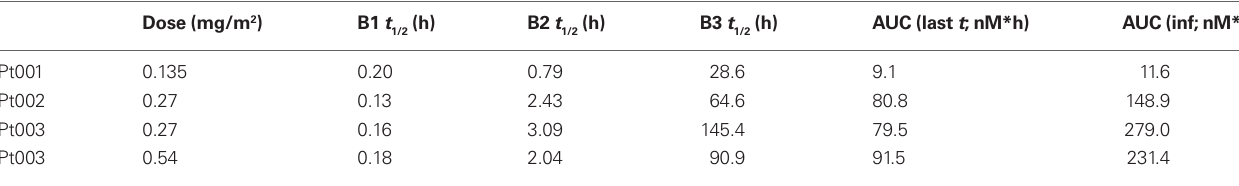
Table 3 | Pharmacokinetic parameters of Pc 4 in the elimination phase data